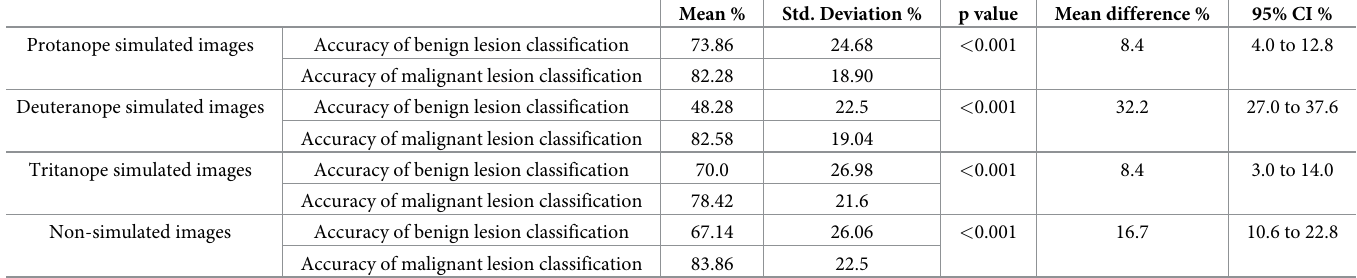
Table 1. The mean accuracy of classifying lesions presented in the images in each set (i.e., protanope, deuteranope, tritanope simulated images and non-simulated images) as either benign or malignant lesions. As well as, the mean difference in classification accuracy between images containing benign and malignant lesions.